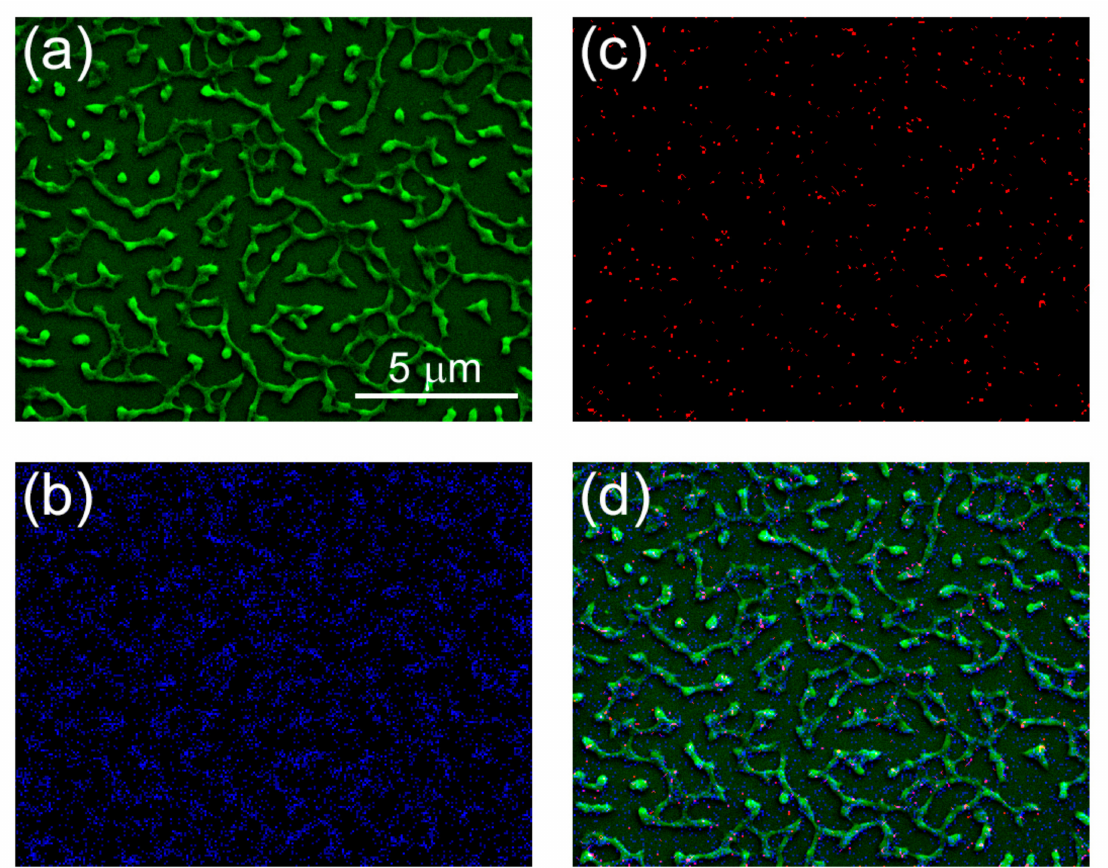
Figure 5. Scanning electron microscopy ( a ), combined with energy-dispersive X-ray spectroscopy, for carbon ( b ) and silver ( c ) of the Retinin-based nanocoatings, incorporating silver nanoparticles. ( d ) The merge of panels ( a – c ). Note, the overlap of carbon signals with the nanostructures, additionally, incorporates speckles of silver. Note, the bigger scale (15 × 10 µ m) than in AFM images